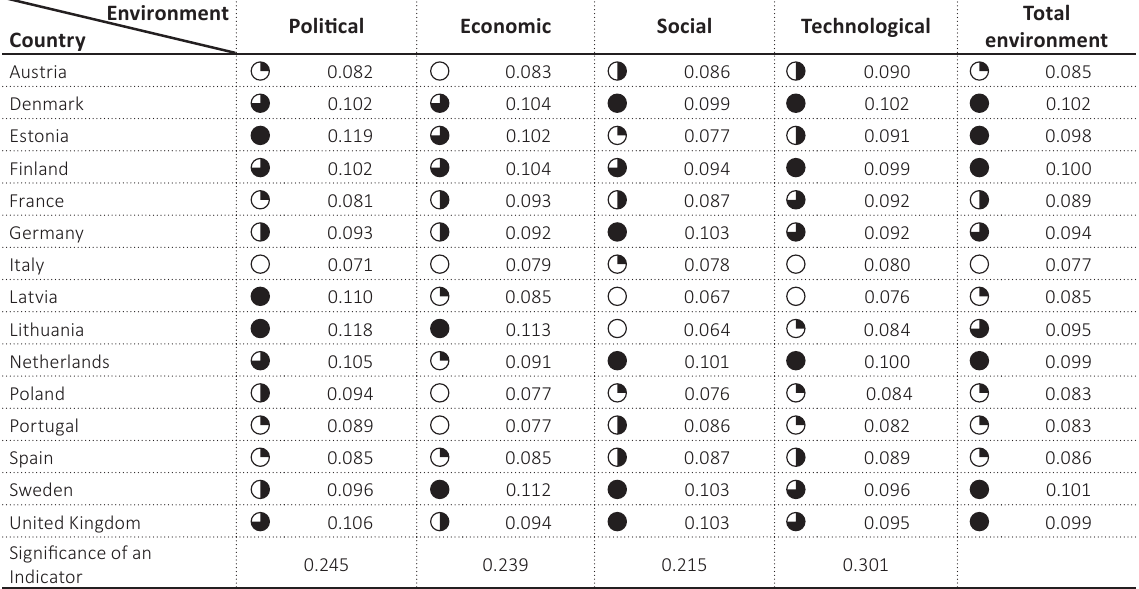
Table 2. FinTech PEST environment assessment tool